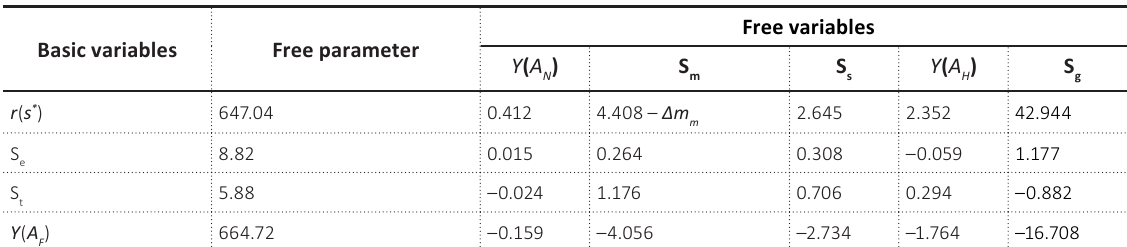
Table 3. Analysis of changes in the price of health and medical services in the final iteration of